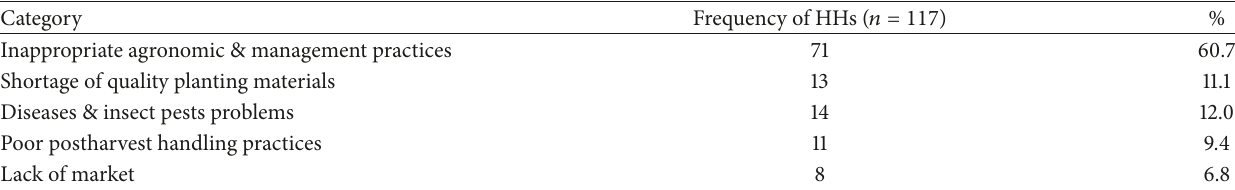
Table 8: Major constraints of date palm production in the study